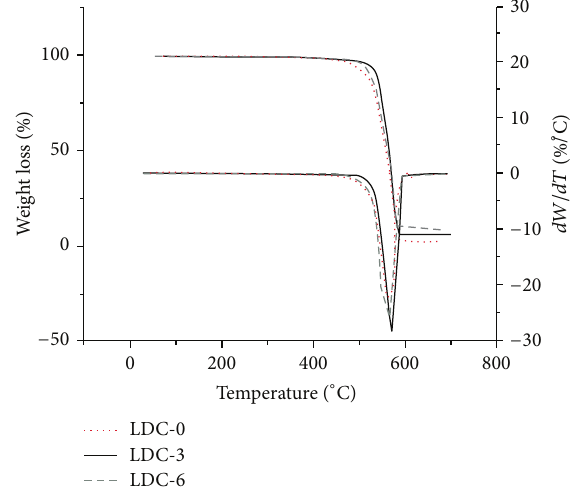
Figure 2: TGA and DTG thermograms of the nanocomposites film. LDC: LDPE/RH/MAPE (90 :4 :6 wt%) composites film reinforced with different MMT content (0, 3, and 6 wt%)